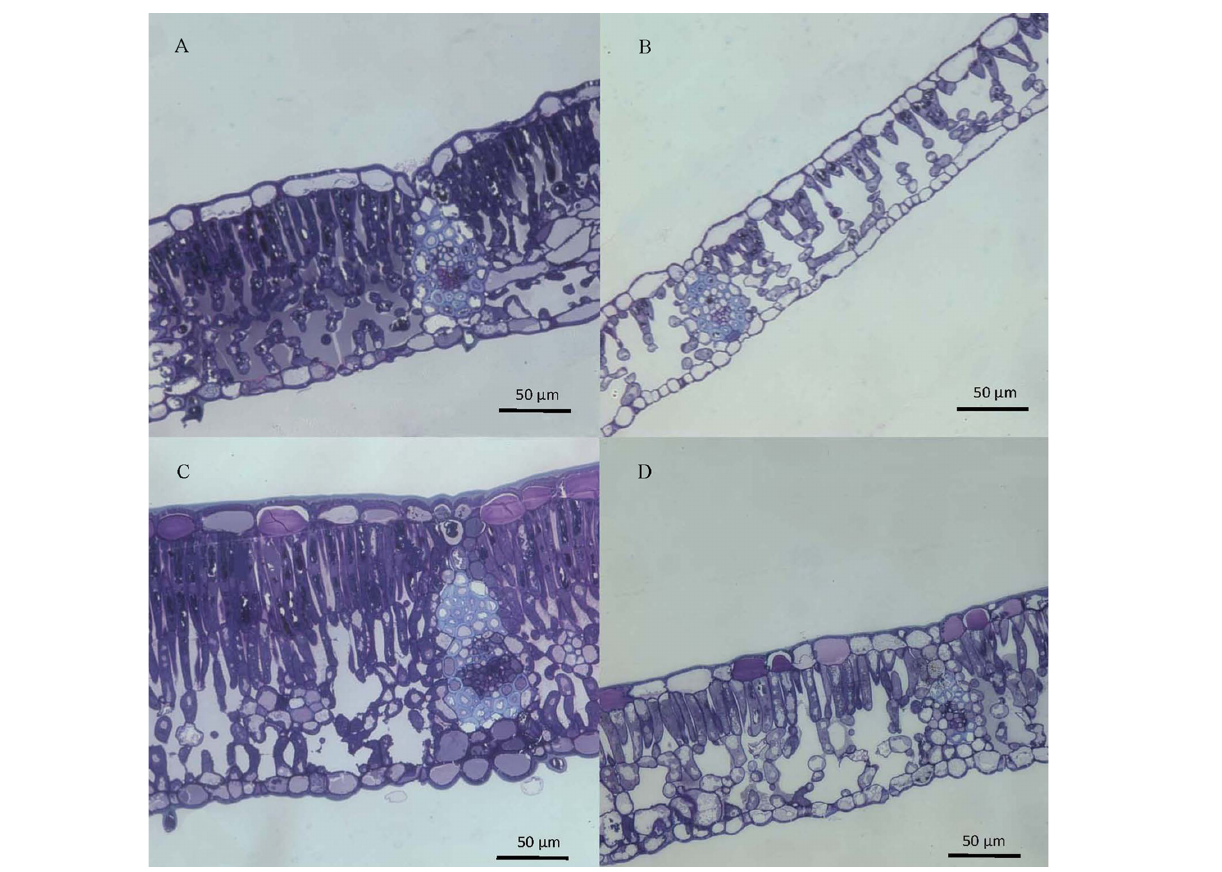
FIGURE 2 | Cross-sections of beech (A,B) and sessile oak (C,D) leaves, collected from upper (A,C) or lower (B,D) tree canopy positions, stained with toluidine blue and observed by optical